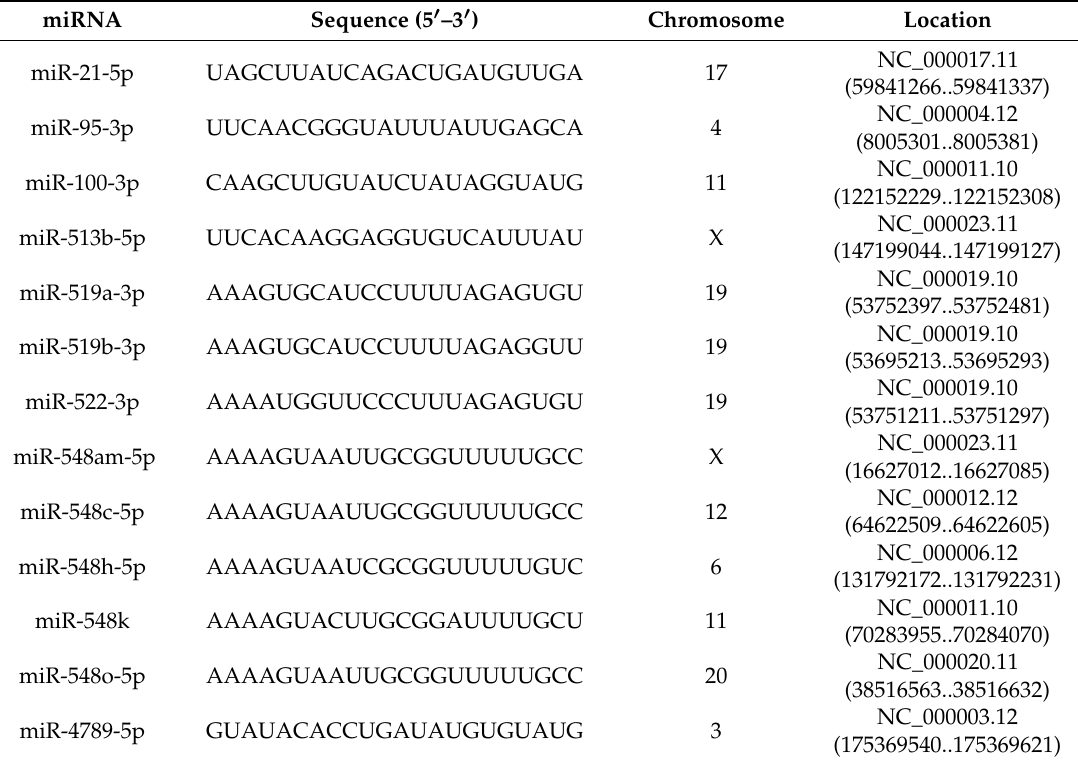
Table 1. The largest group of structural isomers among all the human microRNA, and their individual gene location. Three of the structural isomers listed below have identical RNA sequence, which could be the results of gene